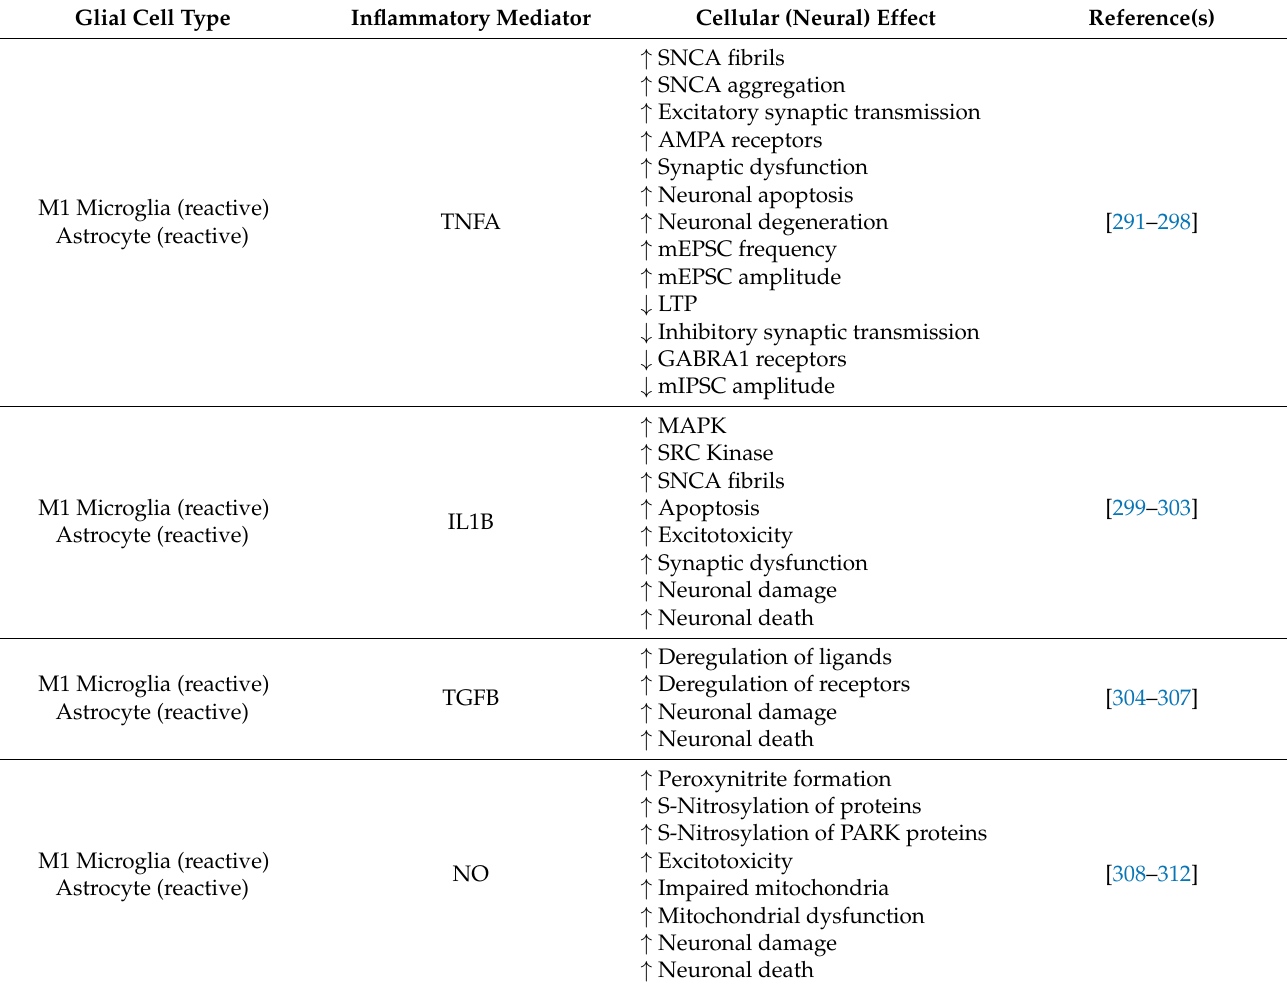
Table 4. Glial inflammatory mediators associated with Parkinson’s